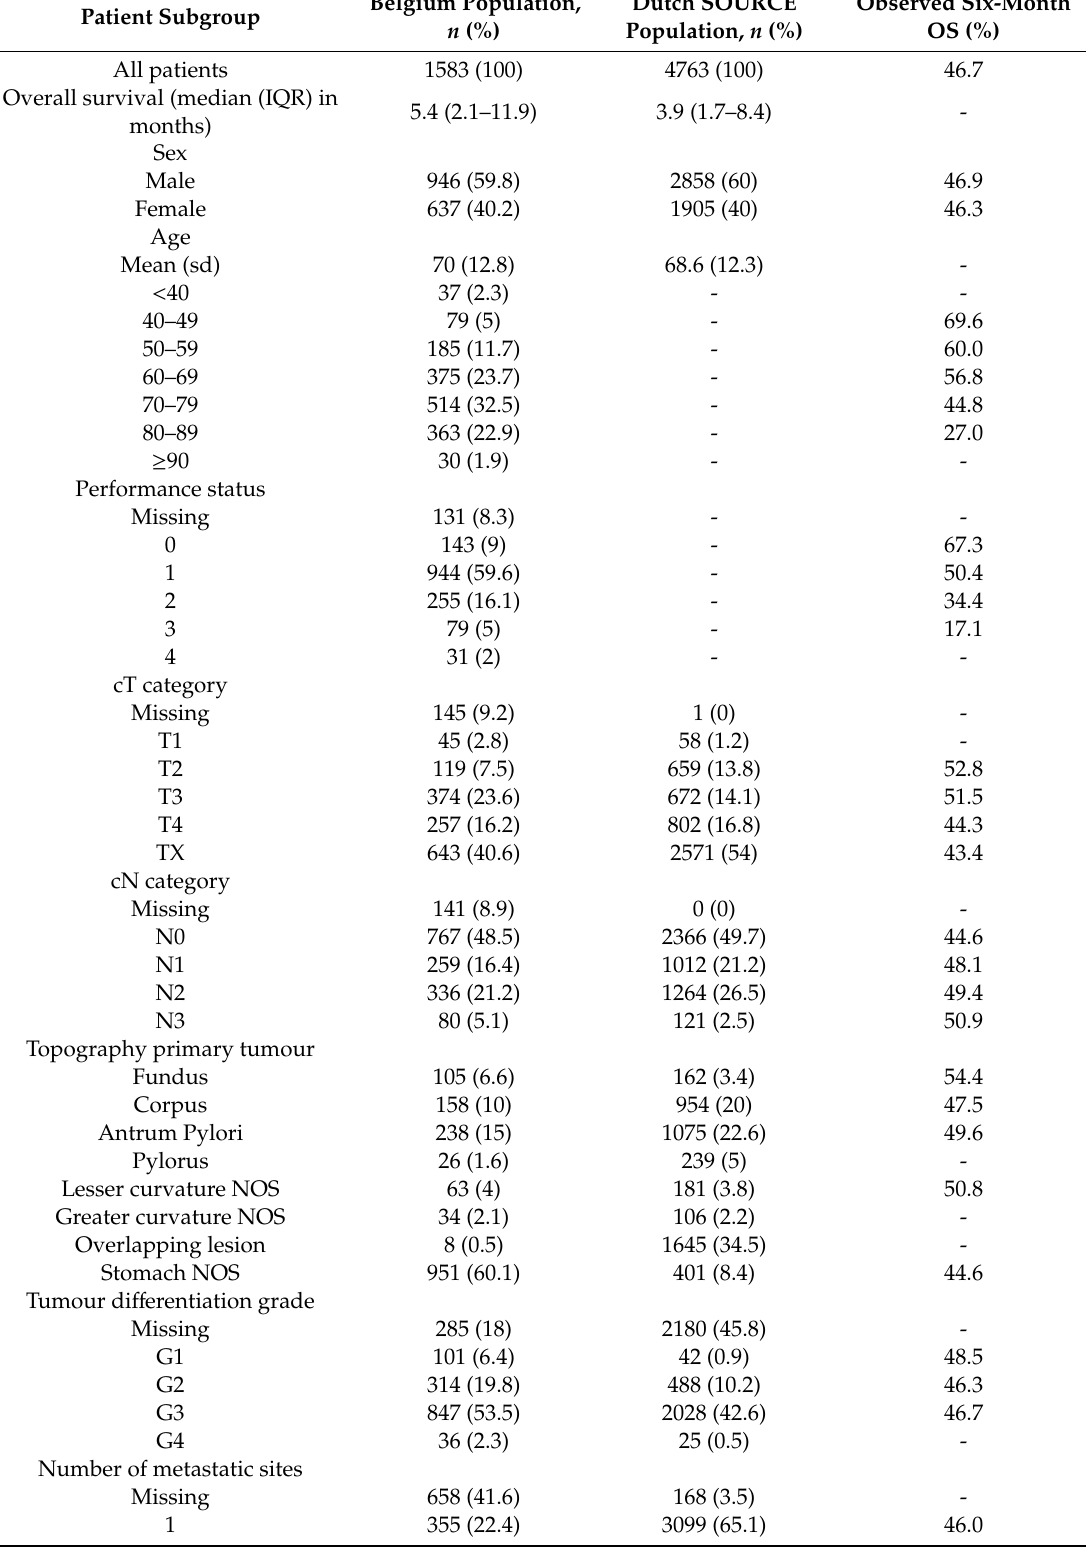
Table 3. Observed six-month overall survival of the Belgian cohort and baseline characteristics of the development (Dutch) and validation (Belgian) gastric cancer cohort. NOS: Not Otherwise